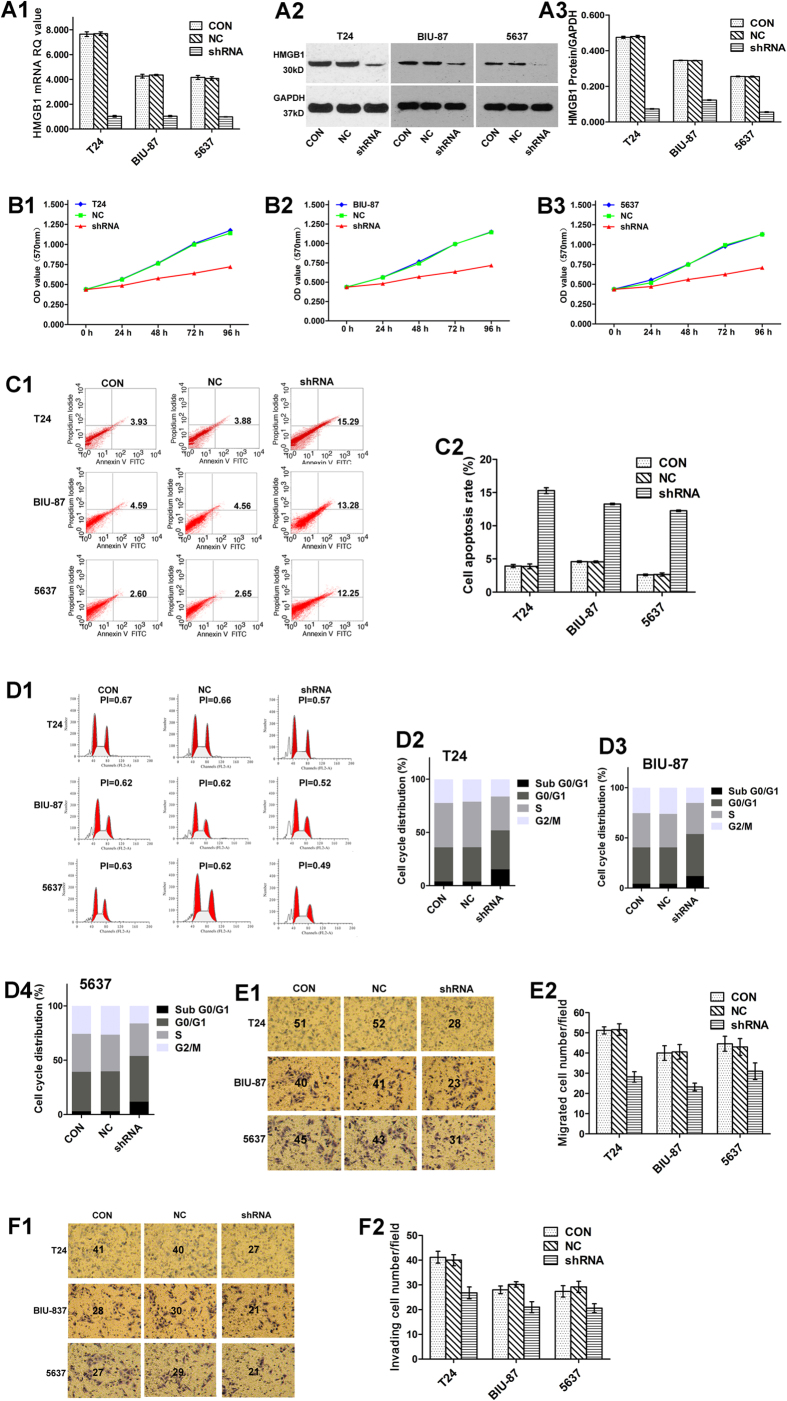
Knockdown of HMGB1 expression inhibits the biological behaviour of BUC cell lines.Figure 2A1, A2 and A3: HMGB1 expression of BUC cell lines was detected in groups after different transfections, which resulted in the differential expression of HMGB1 among the groups in each BUC cell line. The results indicated that the HMGB1 shRNA plasmids significantly inhibited the expression of HMGB1 compared with the CON and NC groups (all P < 0.001). No significant differences were found between CON and NC in three BUC cell lines (all P > 0.05). Figure 2B1, B2 and B3: Cell proliferation of BUC cell lines evaluated by MTT assay showed that knockdown of HMGB1 expression (shRNA group) resulted in lower cell proliferation than in the CON and NC groups (all P < 0.05). Figure 2C1 and C2: Cell apoptosis assays for BUC cell lines indicated that knockdown of HMGB1 expression induced cell apoptosis compared with the CON and NC groups (all P < 0.05). Figure 2D1, D2, D3 and D4: Cell cycle phase assays for BUC cell lines demonstrated that knockdown of HMGB1 expression led to an increase in the percentage of cells in G0/G1 phase, with a significantly lower proliferation index (PI) than the other groups (all P < 0.05). Figure 2E1, E2, F1 and F2: Cell migration and invasion assays confirmed that knockdown of HMGB1 expression reduced the migration and invasive ability of BUC cell lines in vitro compared with the CON and NC groups (all P < 0.001).